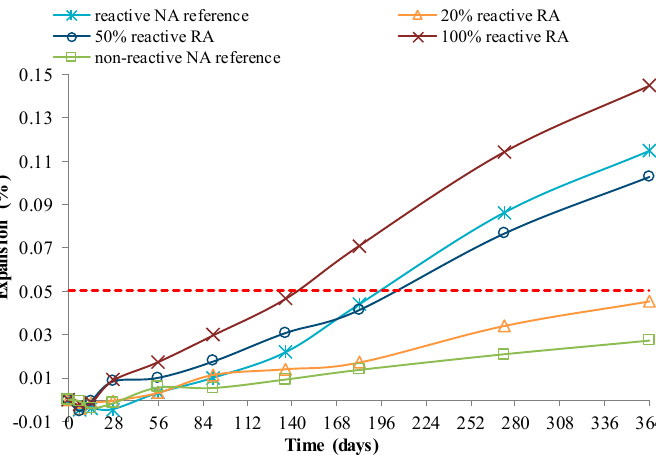
Figure 9. Evolution of the expansion in non-reactive concrete mixes using the RILEM AAR-3 method [82].